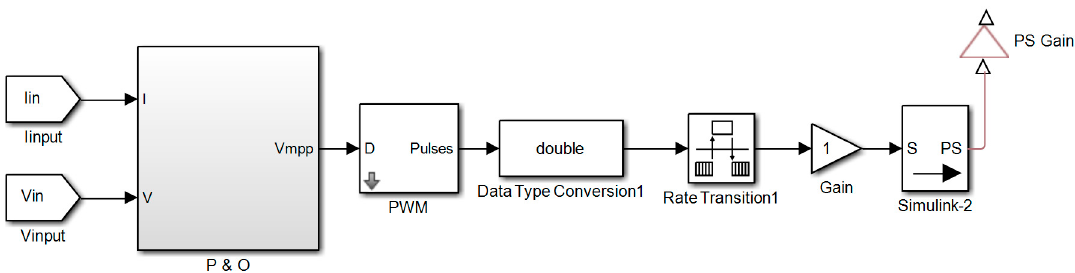
Figure 9 . P&O block.